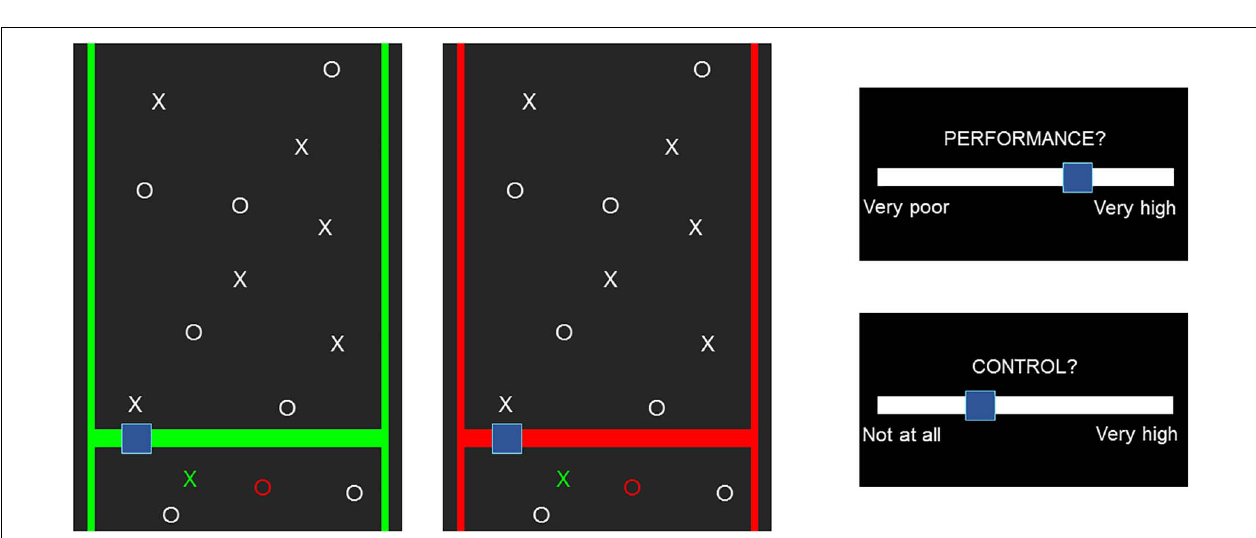
FIGURE 1 | Study design. Participants underwent 50 Hz over the rPPC and Vertex, randomly assigned, in a cross-over fashion. The results were compared with a previously published sample undergoing 30-Hz cTBS in a similar manner.